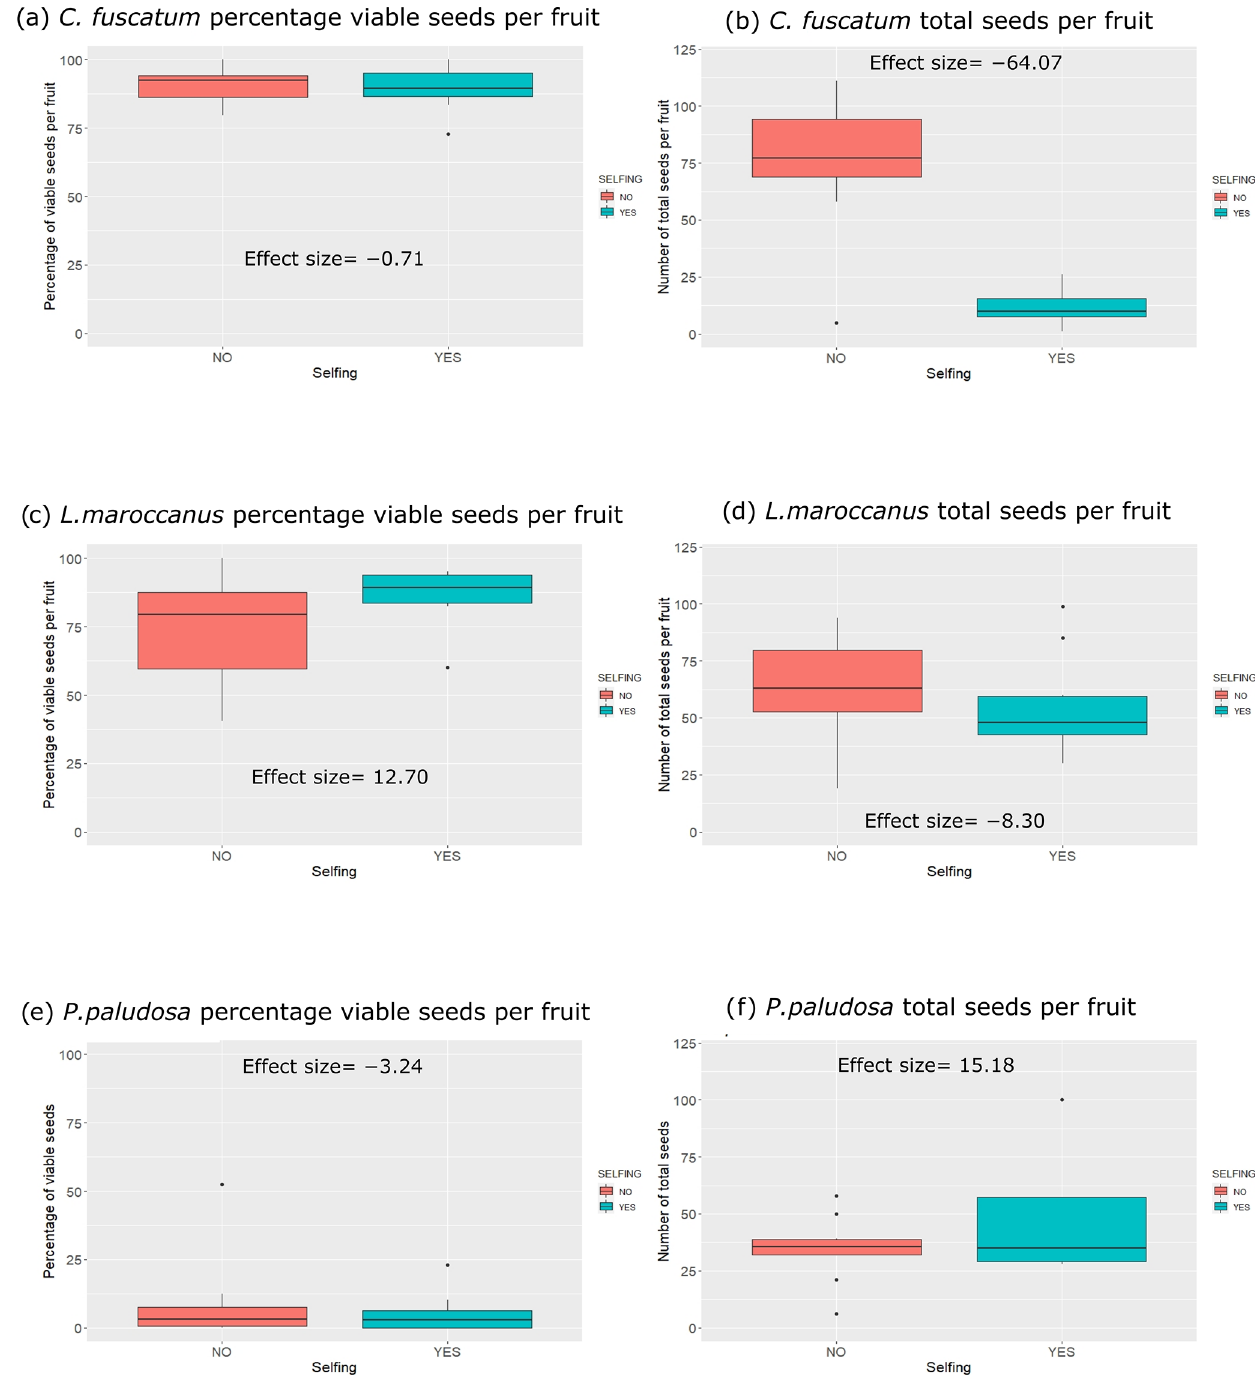
Figure A5. Differences for each plant species considering the seed set and the individual total seed set of the selfing experiment (with or without pollination). In the left column of the plots, we have the percentage of individual total seed sets per species per treatment, and in the right column we have the number of total seeds (viable and not viable seeds) per species and per treatment. The numbers that appear inside the plot are the effect